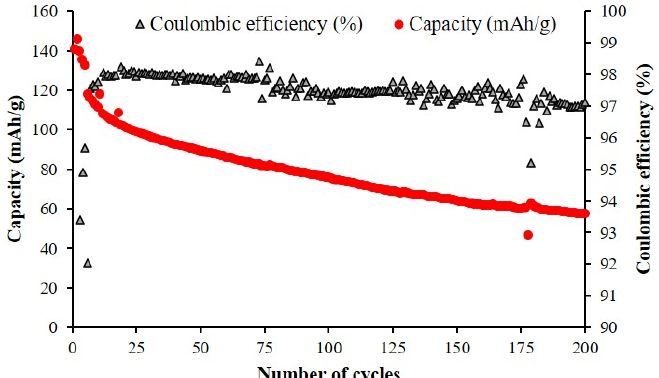
Figure 8. Discharge capacity values for 200 cycles at C/5 (after 5 cycles at C/10) for NMNO-Ti sample.